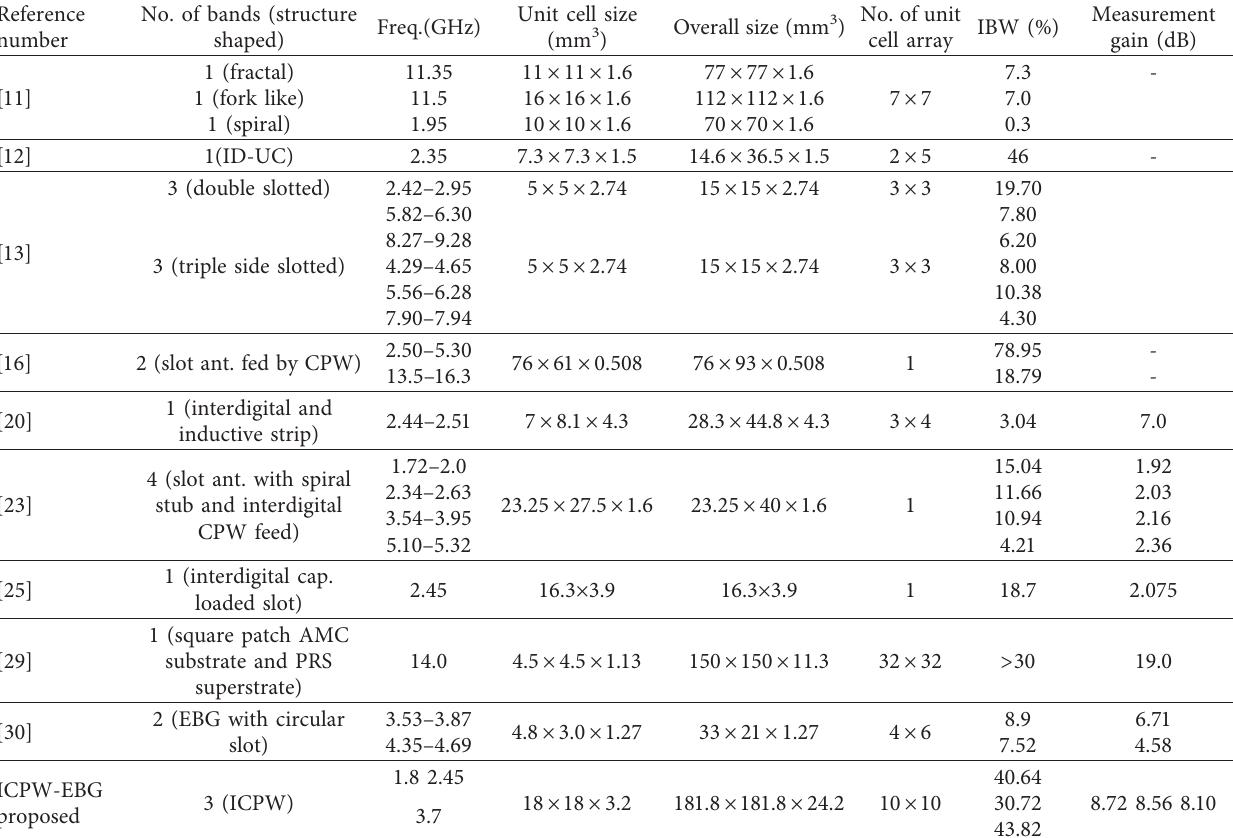
Table 3: Comparison of the presented antenna with reference EBG unit cell and